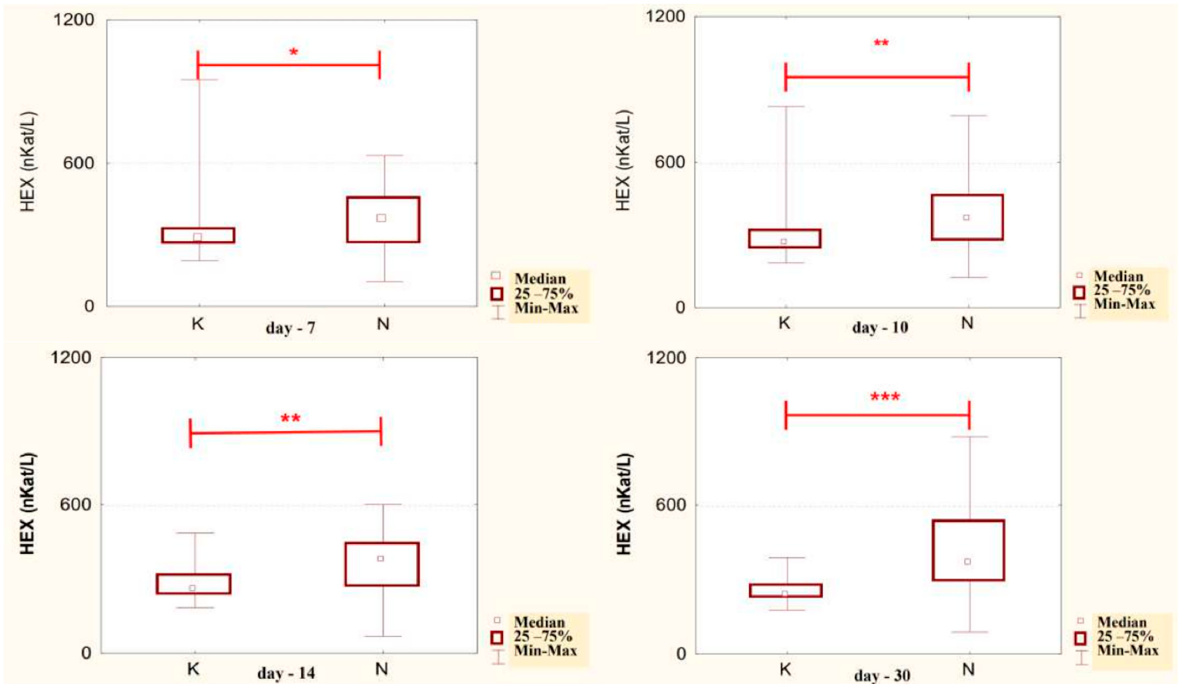
Figure 3. Serum HEX activity concentration (nKat/L) in patients addicted to alcohol and treated with neoglandin (N) compared to the control group patients (K) who were addicted to alcohol but not treated with neoglandin; * p < 0.05, ** p < 0.01, *** p < 0.001. In the urine of alcoholic men not taking neoglandin, the concentration of the HEX activity (nKat/L) was significantly higher ( p < 0.001) on day 1 compared to days 7, 10, 14 and 30 of treatment (Figure 4). Found no significant differences in HEX activity concen- tration (nKat/L) in the urine on days 4, 7, 10, 14, 30, compared to day 1 of treatment for alcohol dependence with neoglandin (Figure 5). Significantly higher ( p < 0.05) concentra- tion of HEX activity (nKat/L) were found in the urine of alcohol-dependent men not treated with neoglandin compared to those taking neoglandin on days 1, 4, 10 and 30 of treatment (Table 2 and Figure 6). In the urine of alcoholic men not taking neoglandin, the concentration of HEX activity calculated per kg creatinine ( μ Kat/kgCr) was significantly higher ( p < 0.01) on day 1 compared to day 14 and 30 of treatment (Figure 7). No significant differences in the concentration of HEX activity per kg of creatinine ( μ Kat/kgCr) in the urine were found on days 4, 7, 10, 14, 30 compared to day 1 of treatment for alcohol-de- pendence with neoglandin (Figure 8). A significantly higher ( p < 0.05) concentration of HEX activity after the conversion to kg of creatinine ( μ Kat/kgCr) was found in the urine of men with alcohol-dependence without neoglandin treatment, as compared to those tak- ing neoglandin on days 1, 4, and 7 of treatment (Table 3 and Figure 9). There appears to be a positive correlation between the amount of alcohol consumed and the activity of HEX in the urine in the early phase of alcohol withdrawal, which sug- gests the possibility of using HEX as a marker of the amount of alcohol consumed (Table 4).